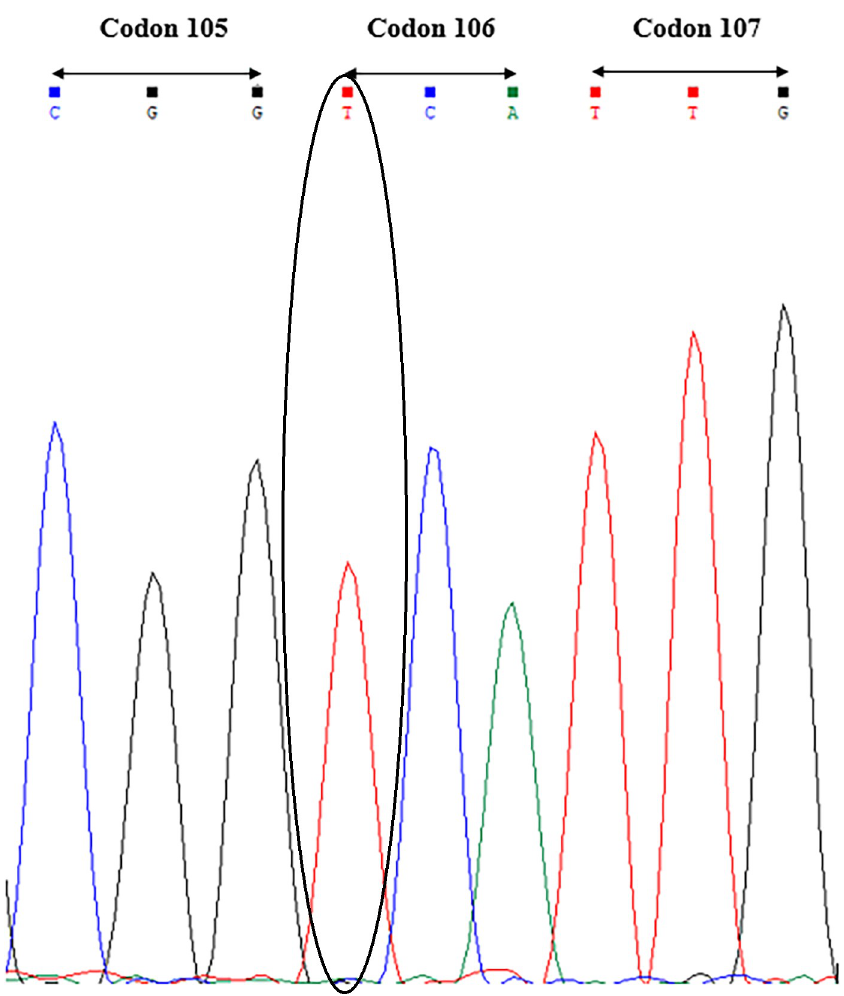
the chromatogram revealed a homozygous state at the first base of codon 106 (circled) identified as the glyphosate resistant T mutation at this position. This non-synonymous mutation indicated both alleles in this glyphosate resistant individual had a Pro (CCA) to Ser (TCA) substitution at codon